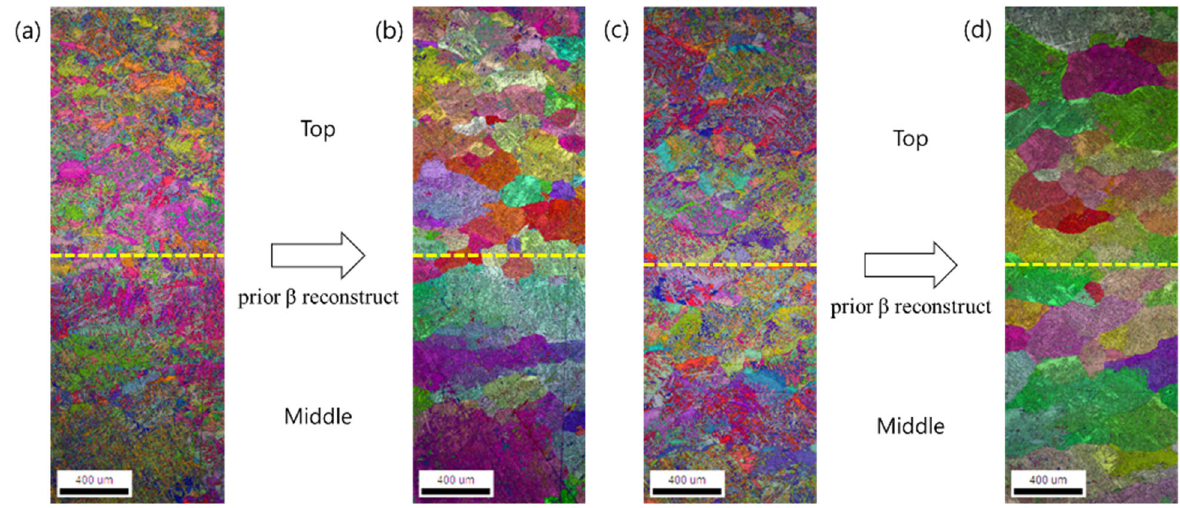
Figure 15. Inverse pole figure map showing ( a , c ) Dynamic Recrystallization, ( b , d ) prior beta recon- structed by EBSD data at ( a , b ) 1050 ◦ C, 1 × 10 − 2 /s, ( c , d ) 1100 ◦ C, 1 × 10 − 2 /s.